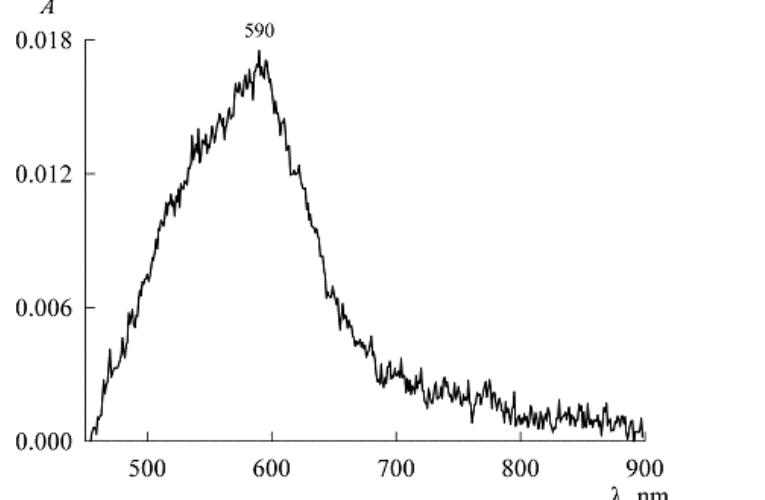
Figure 7. Absorption spectrum of NR in a weak solution of SDS at concentrations c 1 = 1.5 mM and c 2 = 1.4 M.